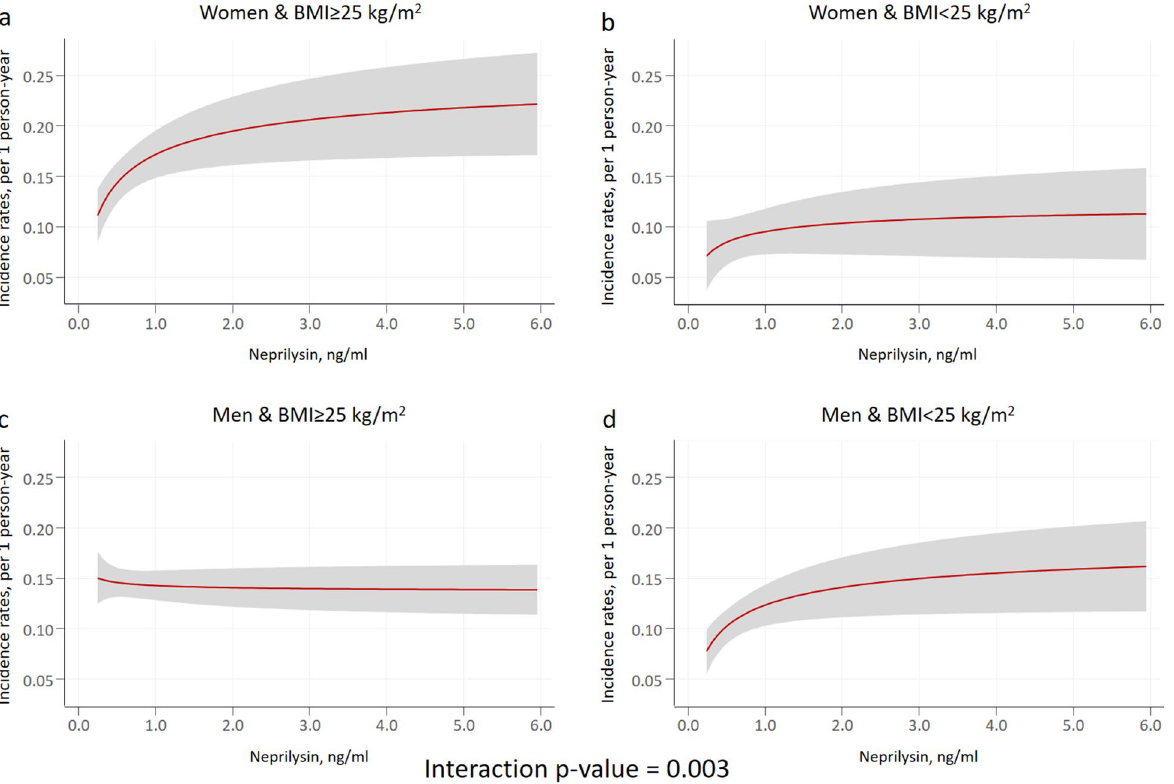
Figure 1. Soluble neprilysin and heart failure admission rates among sex and body mass index categories. Estimates were adjusted for age, HF duration, BMI, NYHA III versus I–II, ischaemic heart disease, systolic blood pressure, heart rate, eGFR, sodium, high-sensitivity troponin T, LVEF, and treatment with ACEI/ARB, beta-blockers, MRA, or loop diuretics. ACEI: angiotensin-converting enzyme inhibitors; ARB: angiotensin II receptor blockers; BMI: body mass index; eGFR: estimated glomerular filtration rate; HF: heart failure; LVEF: left ventricle ejection fraction; MRA: mineralocorticoid receptor antagonist; NT-proBNP: amino-terminal pro- B-type natriuretic peptide; NYHA: New York Heart HF hospitalization risk and sex/BMI categories. The risk for HF hospitalization significantly dif- fered across sex-BMI ≥ 25 kg/m 2 categories (overall p -value < 0.001). However, the two comparisons of interest (women vs. men across BMI groups) were not significant. The IRRs for women versus men when BMI < 25 kg/ m 2 and ≥ 25 kg/m 2 were 0.78, 95% CI = 0.59–1.04; p = 0.092, and 1.08, 95% CI = 0.92–1.28; p = 0.354, respectively. sNEP and risk of HF hospitalization. sNEP was a significant predictor of HF hospitalizations, either when modeled (as the main effect) continuously [FP-0.5] ( p = 0.001) or in quintiles (omnibus p = 0.016). Com- pared to patients in the lower sNEP quintile, patients in the upper quintile had an increased risk of HF hospitali- zations (IRR = 1.29; 95% CI: 1.06–1.58; p = 0.013). The incidence rates of this endpoint along the continuum of sNEP across the evaluated subgroups are shown in Fig. 1. The interaction analysis revealed a differential prog- nostic effect of sNEP (modeled as continuous with FP [-0.5]) across sex and BMI categories for HF hospitaliza- tions ( p -value for interaction = 0.003). Indeed, the sNEP trajectory showed a positive and non-linear association in women with BMI ≥ 25 kg/m 2 compared to the men counterpart ( p = 0.039) (Figs. 1 and 2a). Differences in gender were not present when BMI < 25 kg/m 2 ( p = 0.078) (Figs. 1 and 2b). Table 3 shows the estimates of risk (women vs. men) for different values of sNEP across BMI status. A subgroup analysis stratifying the samples across LVEF (≤ 40% and > 40%), with the same multivariate set- ting, suggests that the direction and magnitude of the excess risk attributable to higher sNEP in women with BMI ≥ 25 kg/m 2 were found in both subgroups (Supplementary Fig. 1). In a sensitivity analysis, we confirmed the differential sNEP gradient of risk across sex and BMI strata when BMI was categorized by the median value (Supplementary Fig. 2). sNEP and mortality risk—interaction analysis. In multivariable analysis, sNEP (main effect) (mod- eled as continuous with FP [-0.5]) was not associated with mortality risk ( p = 0.241). The prognostic effect of sNEP on mortality did not significantly differ across sex and BMI categories ( p -value for interaction = 0.072; Fig. 3). Indeed, any of the two comparisons of interest (women vs. men in the two BMI groups (BMI ≥ 25 kg/ m 2 vs. BMI < 25 kg/m 2 ) were not significant ( p = 0.563 and p = 0.064, respectively) (Figs. 4a, b). Worth noting,